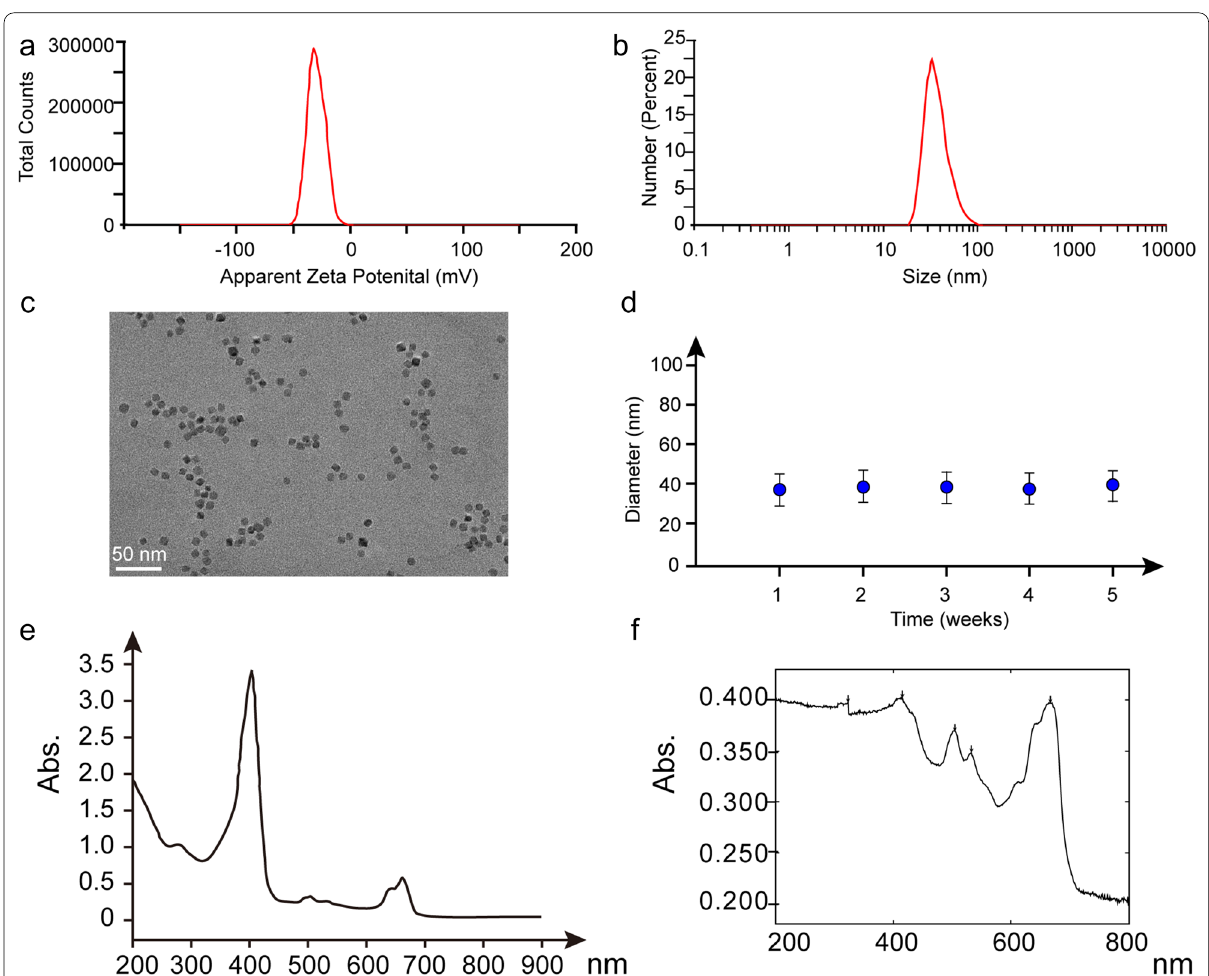
Fig. 2 Characterization of IONPs. a Zeta potential of USIONPs using a Zeta Potential Device; b Hydrate particle size of USIONPs using a Particle Analysis Device; c Core particle size of USIONPs under TEM; d Colloid stability analysis of USIONPs; e Ultraviolet–visible absorption spectrometry analysis of chlorin E6; f Ultraviolet–visible absorption spectrometry analysis of